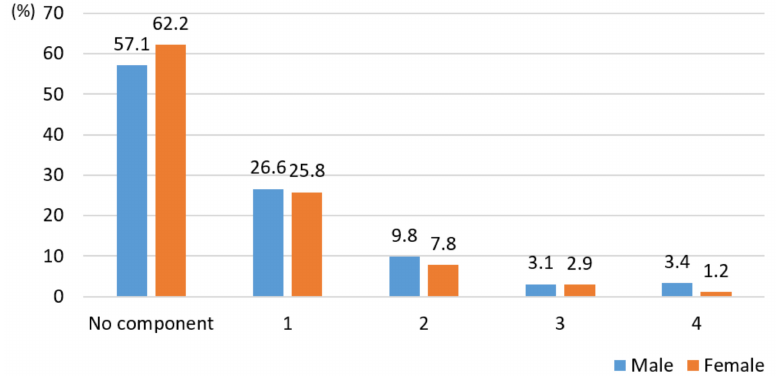
Figure 2. Association between the number of metabolic syndrome components and sex (n = 1310). Metabolic syndrome components: waist circumference, blood pressure, fasting glucose, triglycerides, and high-density lipoprotein cholesterol ( χ 2 = 7.502, p =